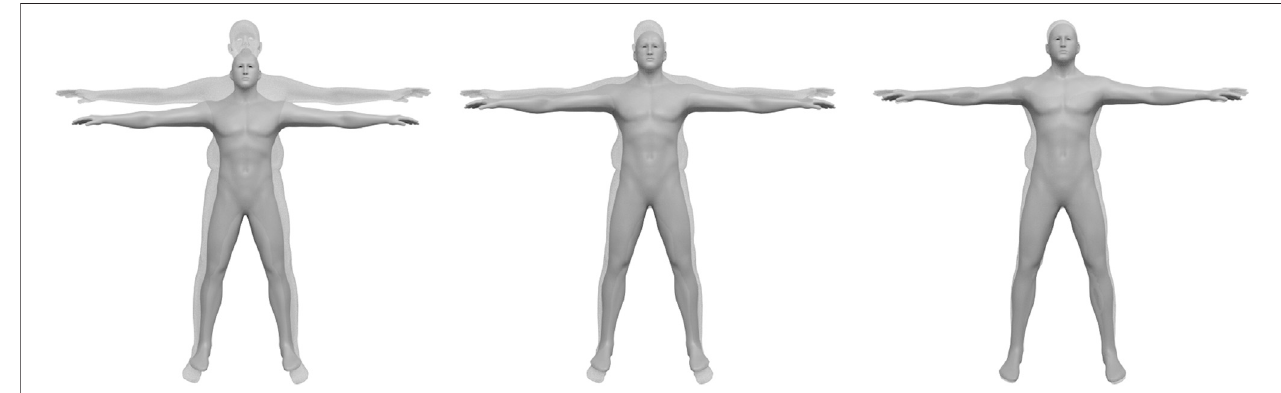
FIGURE 6 | Scaling the template (opaque) to match the scan (semi-transparent): The pre-processing aligns the scan with the template and puts it into the same pose (left) . Body height and limb lengths of the template are then adjusted by a global uniform scaling (center) , followed by local scaling for limbs and spine (right) .